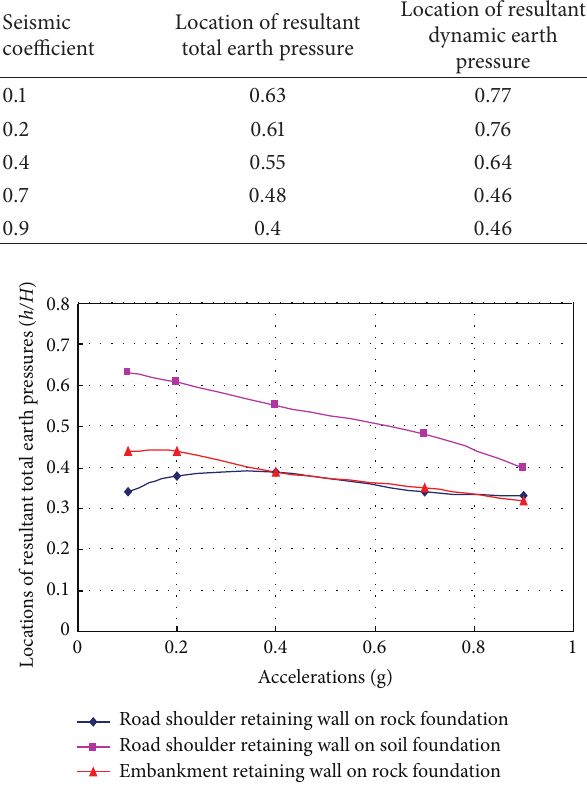
Figure 11: Locations of resultant total earth pressures ( h/H ).